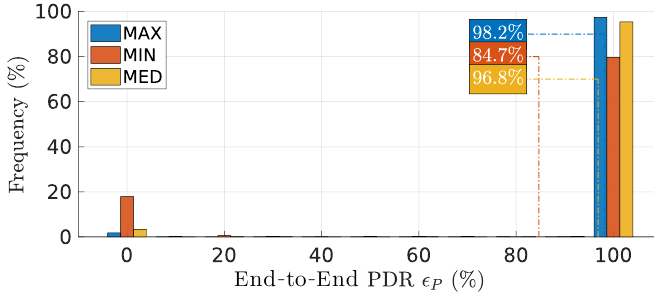
Figure 12. Distribution of end-to-end packet delivery ratio (cid:101) P over the mission